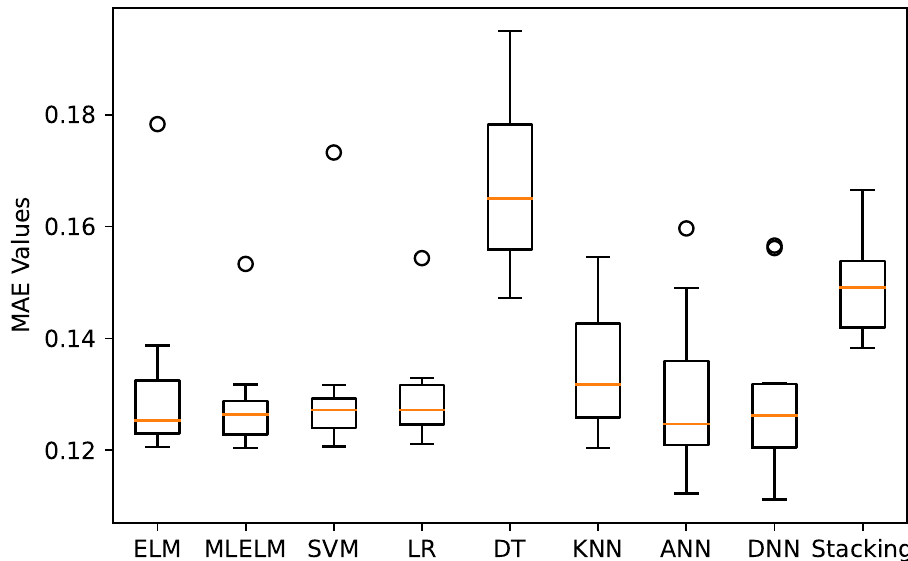
Figure 8. The performance of various models for annual building energy consumption: MAE comparison.